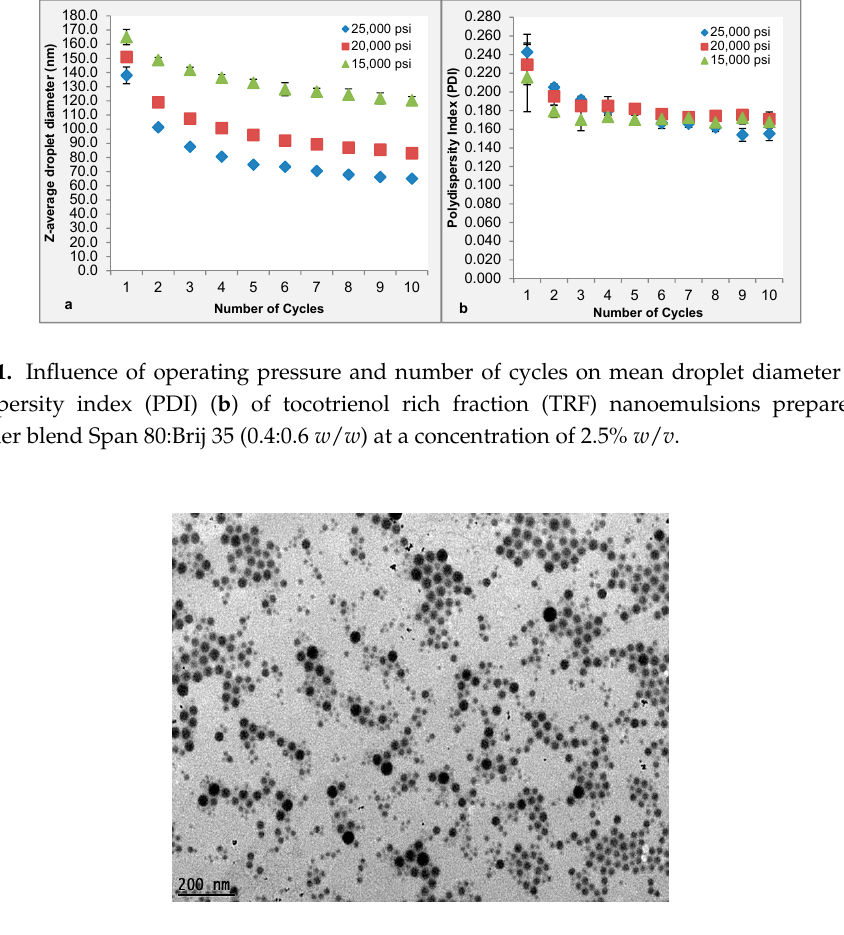
Molecules 2015 , 20